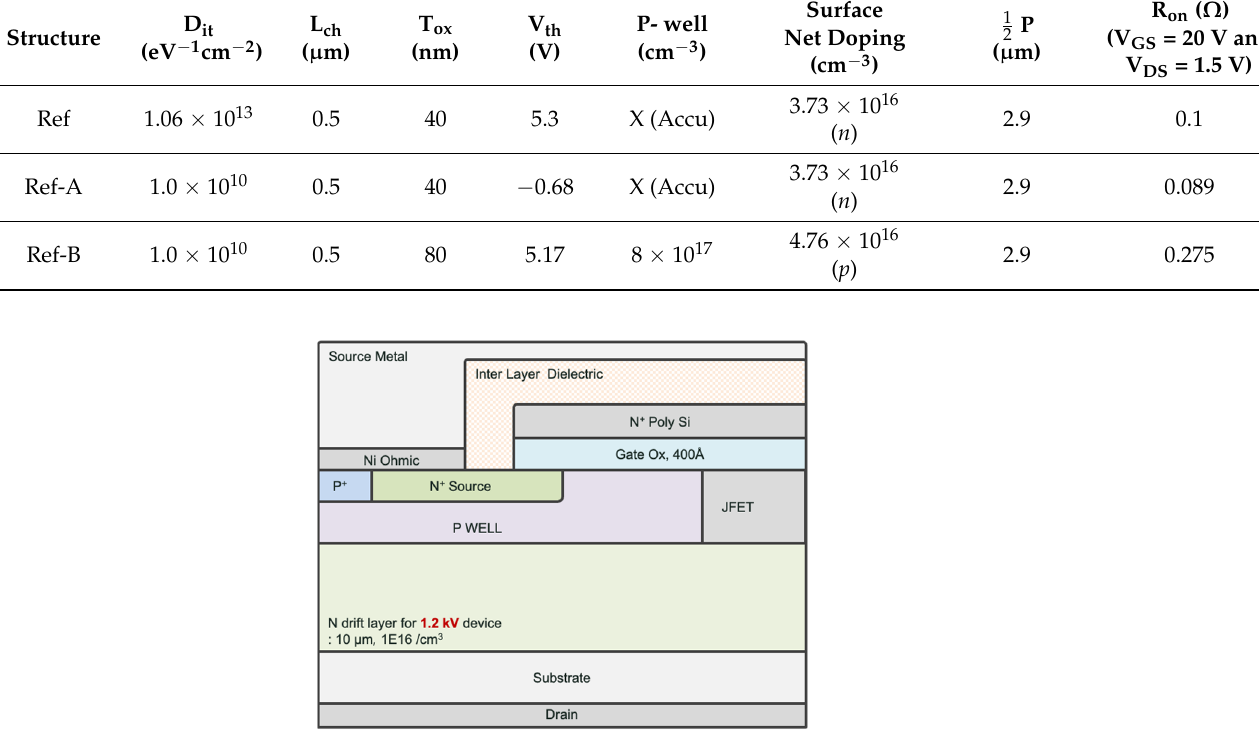
Figure 11. Cross-sectional view of a half-cell of the planar MOSFET.